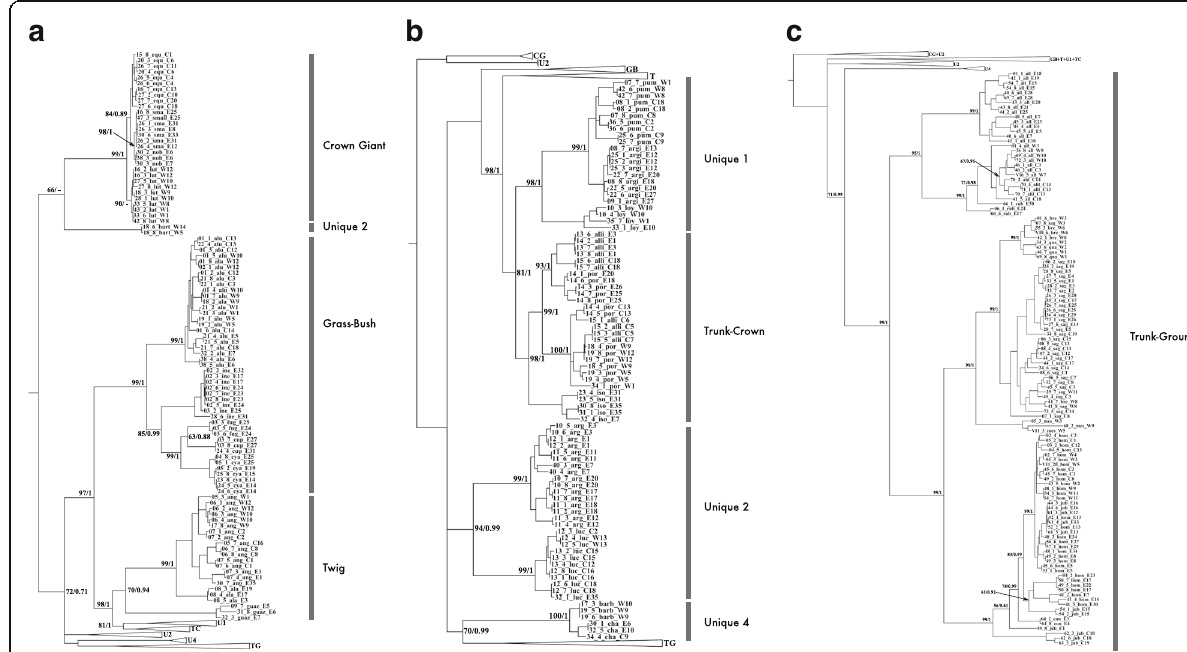
Fig. 2 Maximum likelihood tree (50% majority consensus) based on three genes (2170 bp); 303 individuals from 33 Cuban Anolis species were included as the ingroup and two species from the genus Leiocephalus were included as the outgroup. Node supports are bootstrap percentages from maximum likelihood analyses; Bayesian posterior probabilities are shown only for the major clades. The figure has been split into parts A, B, and C, and some clades have been compressed to fit the full tree; CG, crown-giant; GB, grass-bush; T, twig; TC, trunk-crown; TG, trunk-ground; U1,